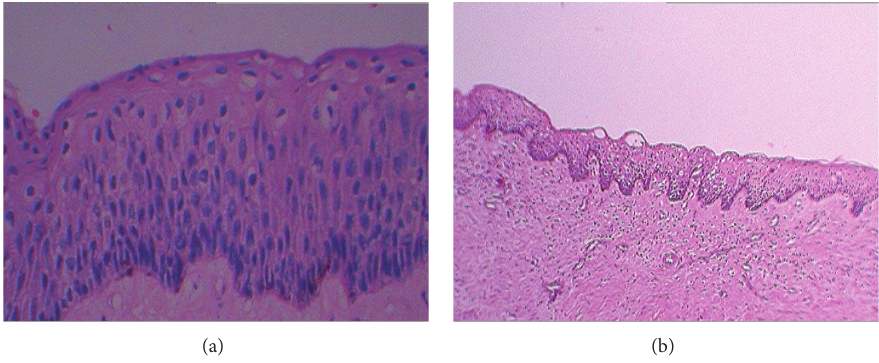
Figure 6: Photomicrograph of the histopathological